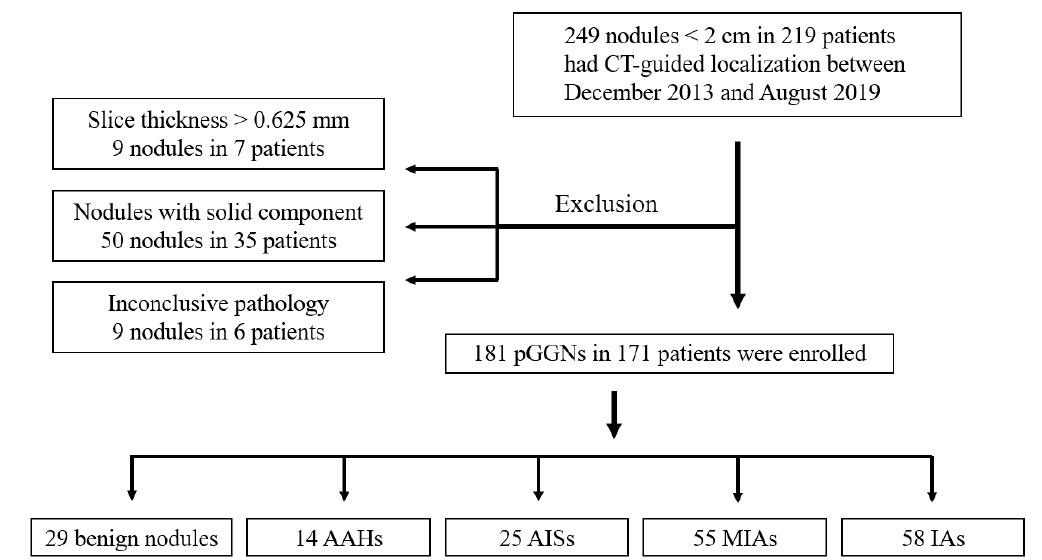
Figure 1. Flowchart of patient selection. CT-guided: computed tomography-guided; pGGNs: pure ground-glass nodules; AAH: atypical adenomatous hyperplasia; AIS: adenocarcinoma in situ; MIA: minimally invasive adenocarcinoma; IA: invasive adenocarcinoma.